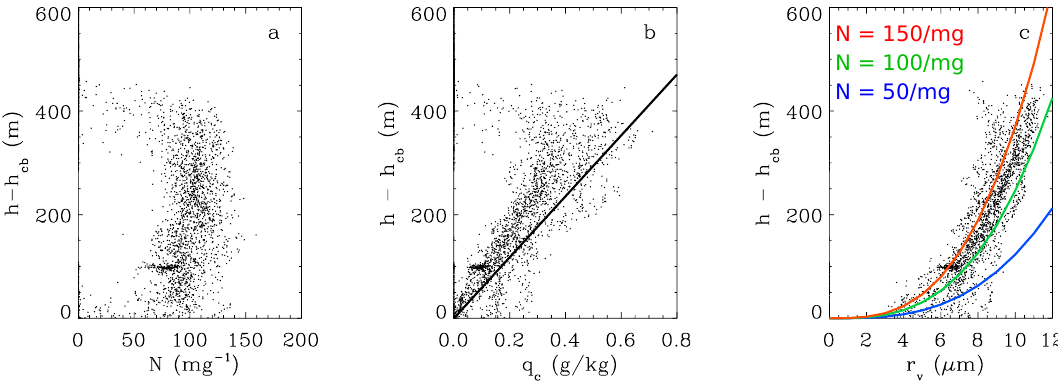
Fig. 3. Experimental data from the stratocumulus cloud layer. (a) Cloud droplet concentration; (b) cloud water mixing ratio; (c) droplet mean volume radius. Vertical axes represent height above the cloud base h cb estimated separately for each cloud penetration by fitting the theoretical function of adiabatic LWC to the experimental data. Color lines in (c) mark profiles of the adiabatic droplet radius for different droplet concentration.